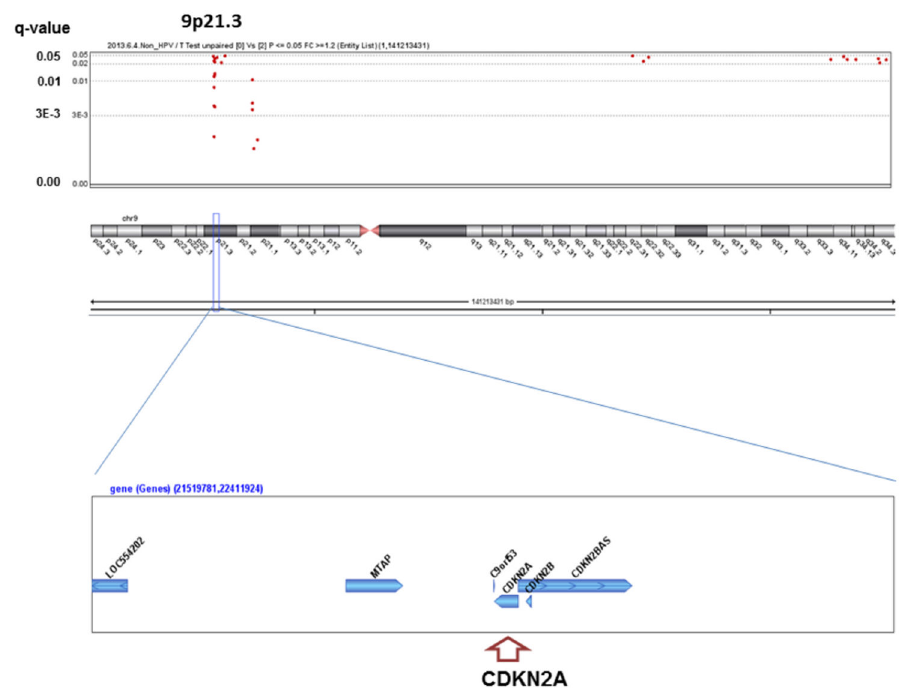
Figure 1. Significant SCNAs at 9p21.3 associated with heavy alcohol consumption.